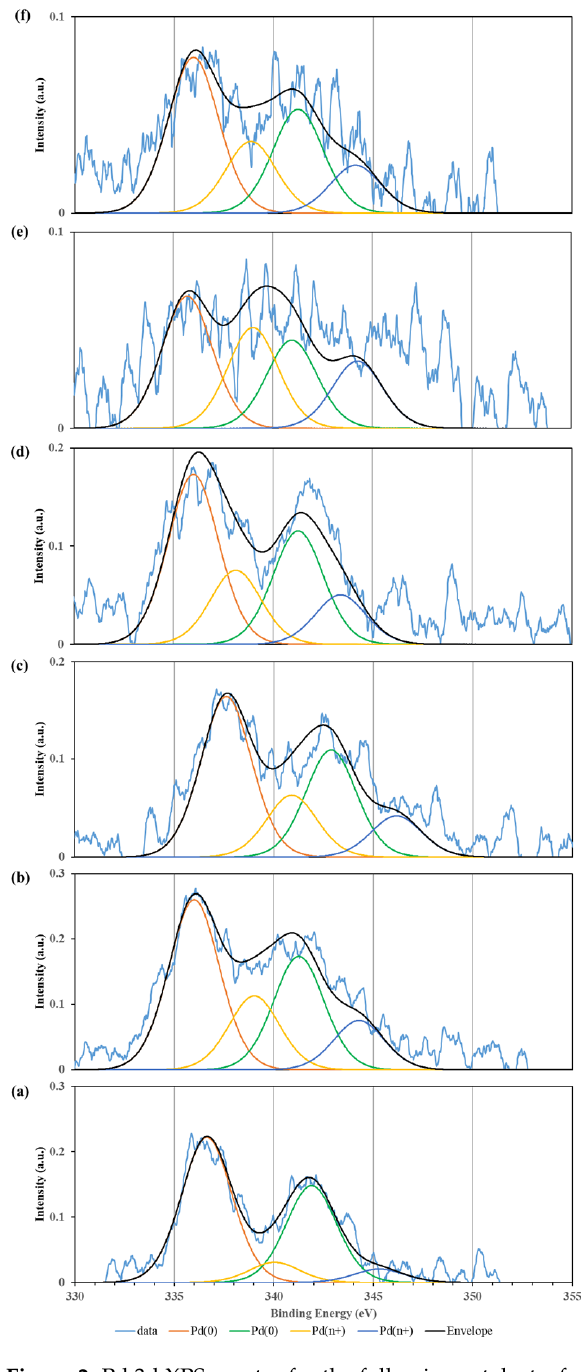
Figure 2. Pd 3d XPS spectra for the following catalysts: fresh, reduced ( a ) and used ( b ) IP-Pd; fresh reduced ( c ) and used ( d ) DS-Pd; fresh reduced ( e ) and used ( f ) SL-Pd. See text for details. Table 2. Chemical compositions and oxidation states of Pd obtained from XPS analyses for the fresh reduced and used Pd/OMC catalysts.